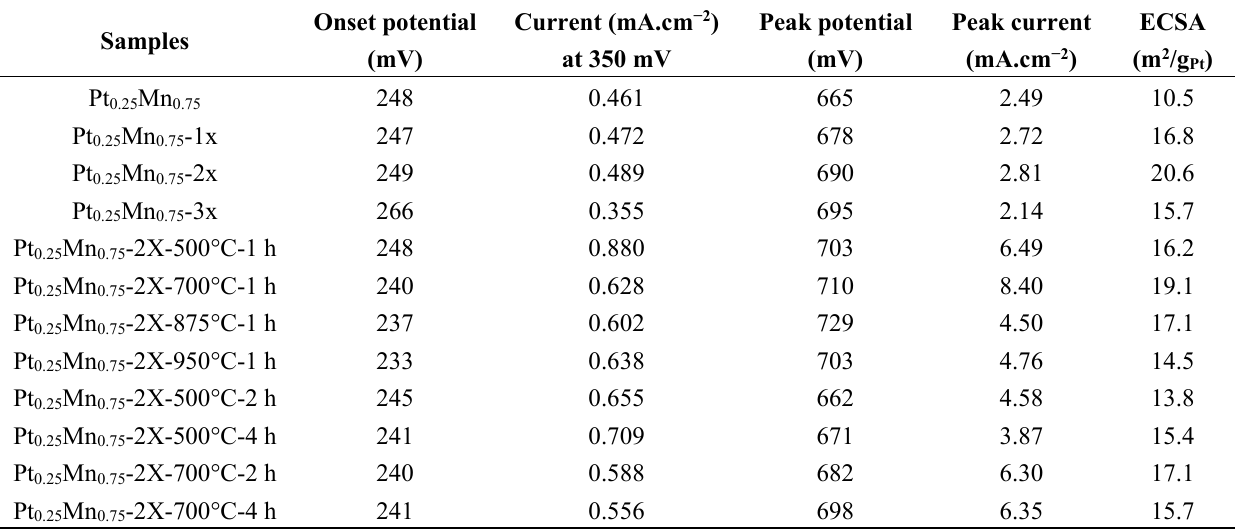
Figure 9. Cyclic voltammetry (CV) in the 0.5 M H 2 SO 4 solution at a scan rate of 20 mV/s for samples prepared ( a ) with different sodium citrate contents and then heat treated ( b ) at different temperatures for 1 h and ( c ) at 500 and 700 °C for different periods. Table 3. Summary of ethanol oxidation reaction (EOR) activity parameters of the Pt-Mn samples. Also listed are the measured electrochemical active surface area (ECSA) values for each